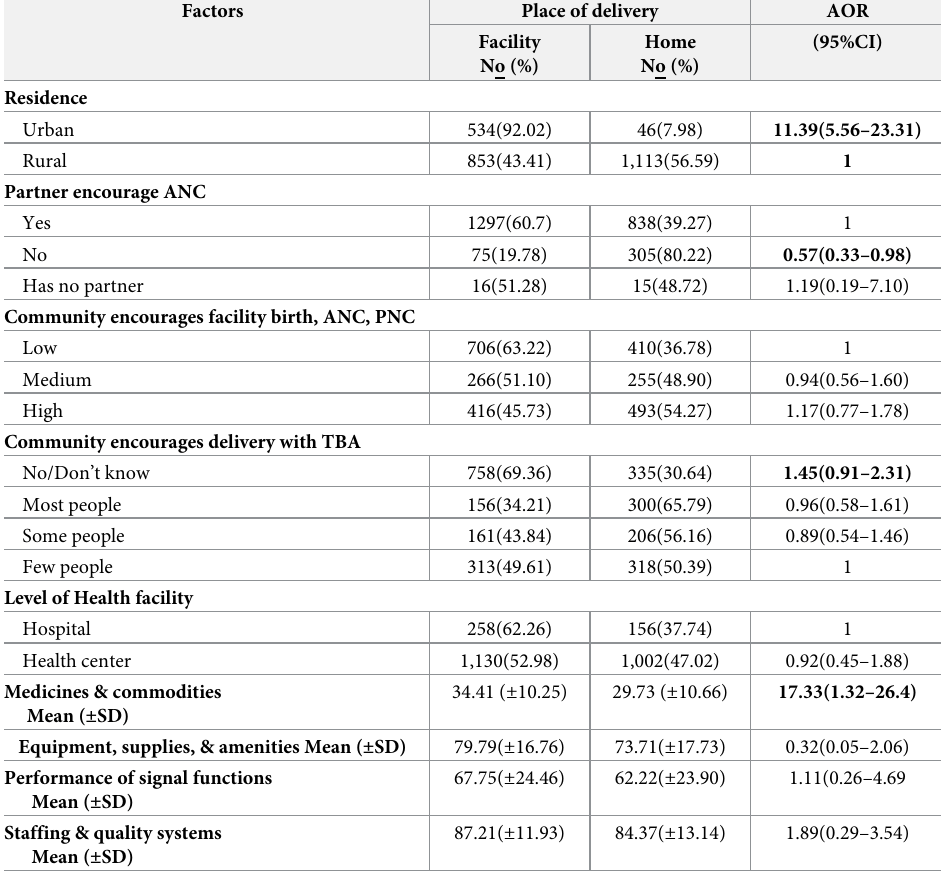
Table 5. Community and health facility related factors associated with place of delivery, PM-Ethiopia